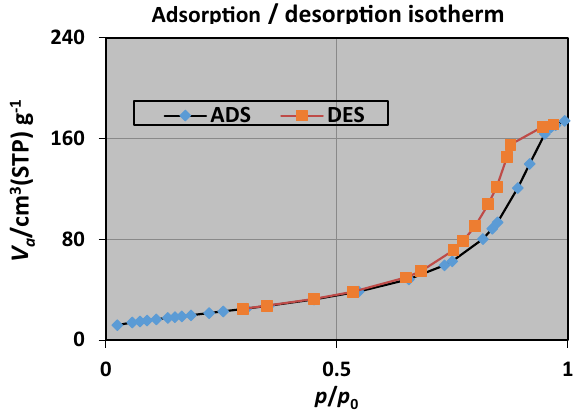
Figure 6. N 2 absorption and desorption diagrams.